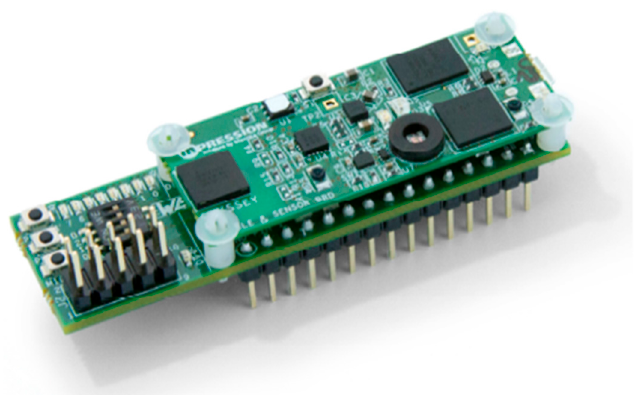
Figure 15. Altera ® MAX 10 FPGA-10M08SAU169C8GES mounted in its development board.